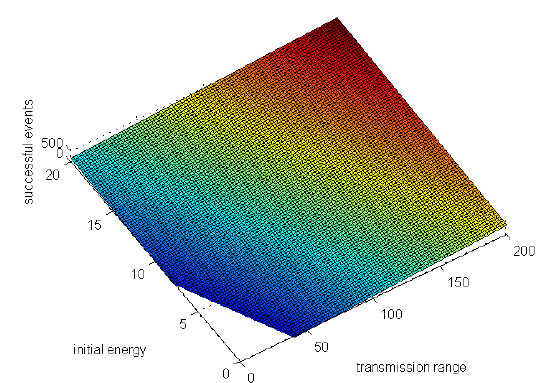
Fig. 11. Mean value for the number of successful events for EAST with neighborhood discovery as a function of the maximum transmission range and the node initial energy